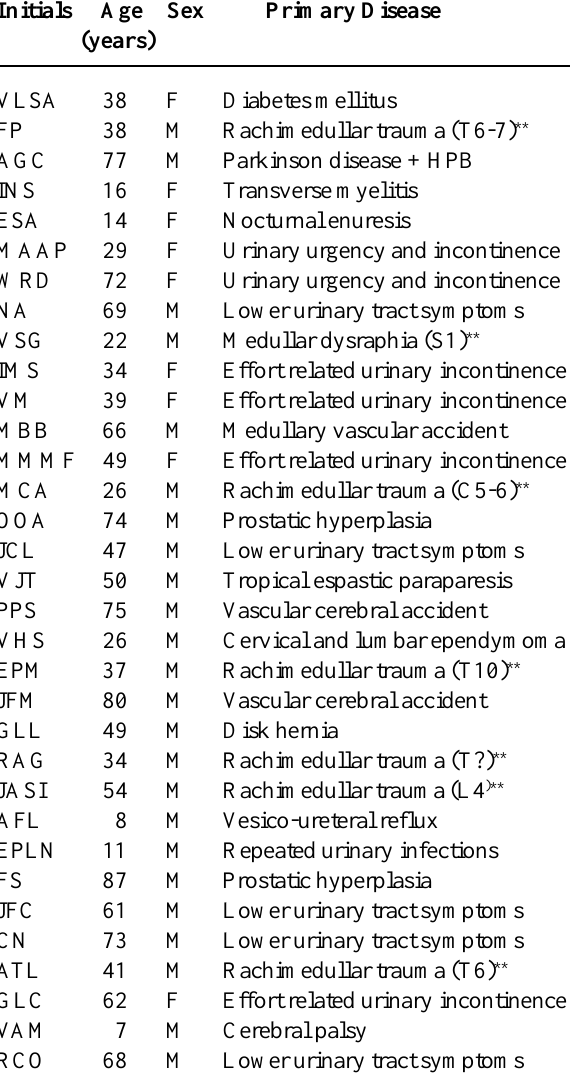
Table 1 – General characteristics of patients